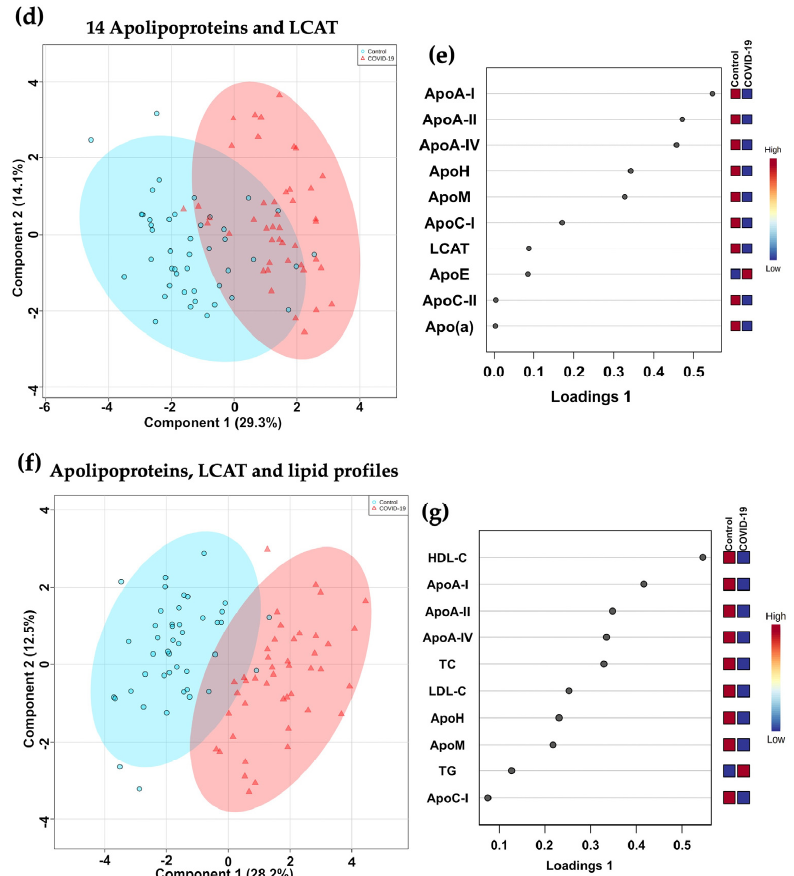
Figure 5. Multivariate analysis of 14 apolipoproteins, LCAT and lipid concentrations from COVID-19 patients and controls. Samples were collected from control subjects ( n = 44) and COVID-19 patients ( n = 44). Principal component analysis (PCA) was performed on the lipid profile ( a ), plasma concentrations of 14 apolipoproteins and LCAT ( b ), and the combination of these characteristics ( c ). Sparse Partial Least Squares Discriminant Analysis (sPLS-DA) of apolipoproteome and plasma LCAT concentration ( d ) was calculated to identify the contribution of each variable to component 1 (Loading 1) ( e ). sPLS-DA of apolipoprotein, LCAT, and lipid profiles of COVID-19 and controls ( f ) was calculated to identify the contribution of each variable to component 1 (Loading 1) ( g ). Blue circles and red triangles represent the control subjects and COVID-19 patients, respectively.